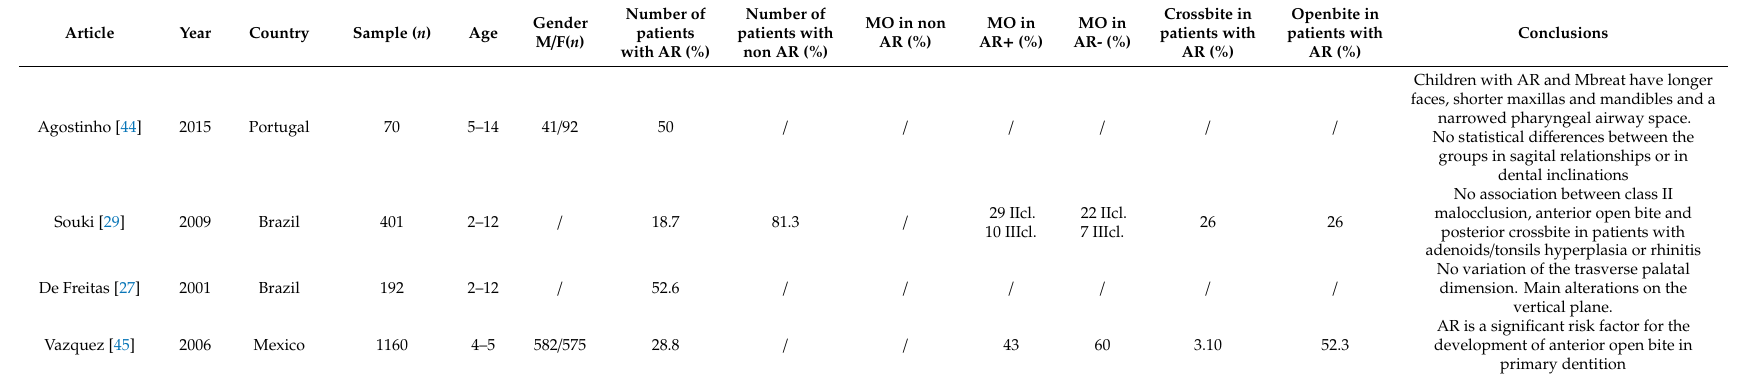
Table 2. Characteristics of the studies considering malocclusion (MO) in pediatric patients with diagnosis of allergic rhinitis (AR). AR + indicates children with diagnosis of allergic rhinitis. AR- indicates children without allergic rhinitis.